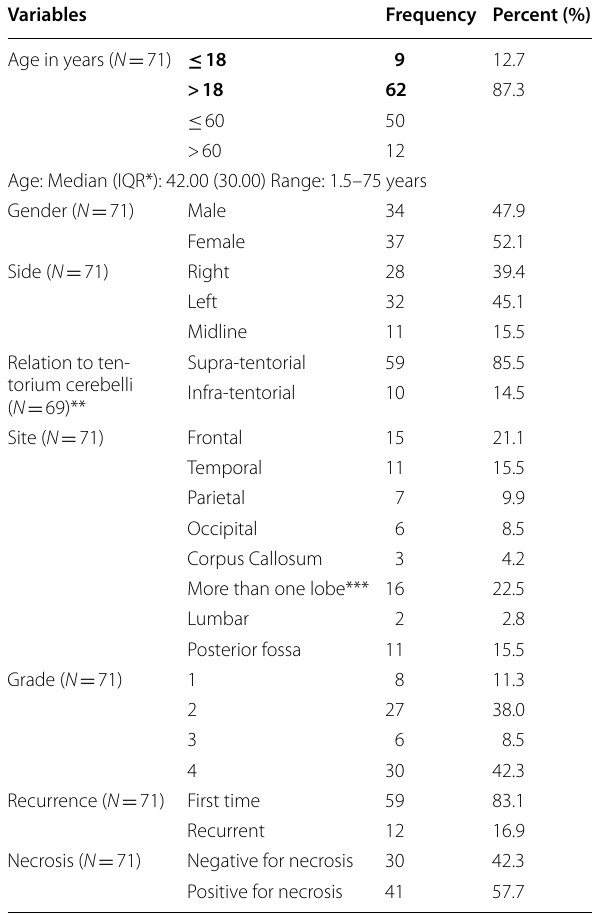
Table 1 Clinico-pathological data of the studied cases; ( N